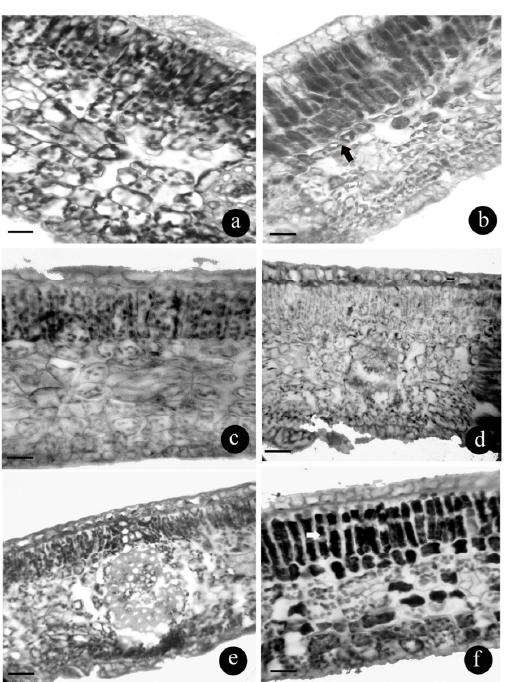
Fig. 3. Anatomical features of the leaf lamina in M. indica, magnification bar, a to f – 10 mm a. ‘Jhumakhiya 2’- 2 layer pallisade, spongy layer cells loosely arranged; b. ‘Sopari’ - 3 compact layer of pallisade cells, continuous layer of spongy below pallisade (arrow); c. ‘Langdo’- single pallisade, spongy compactly arranged; d. ‘Aambadi’- 2 layer pallisade cells, spongy cells loosely arranged; e. ‘Asadiyo’ - single layered pallisade, spongy loosely arranged; f. ‘Neelam’- 3 layers loosely arranged pallisade of different length (arrow), spongy layer cells compactly arranged